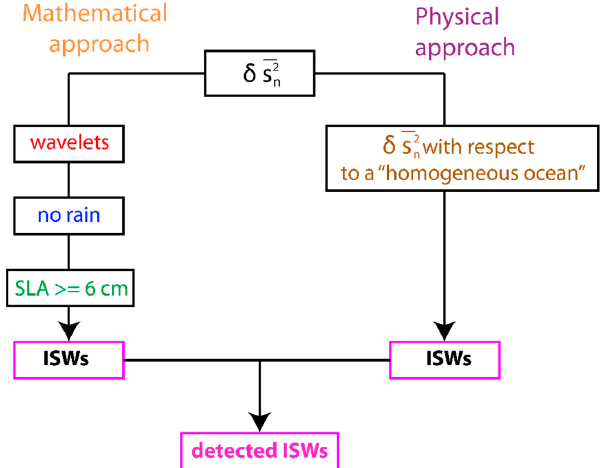
Figure 2. Logic flow of the proposed detection method. Two independent processing schemes are implemented, here denominated “mathematical approach” and “physical approach.” In the end, intersection of the results of those independent approaches gives the positions where internal solitary waves (ISWs) are identified by the method.